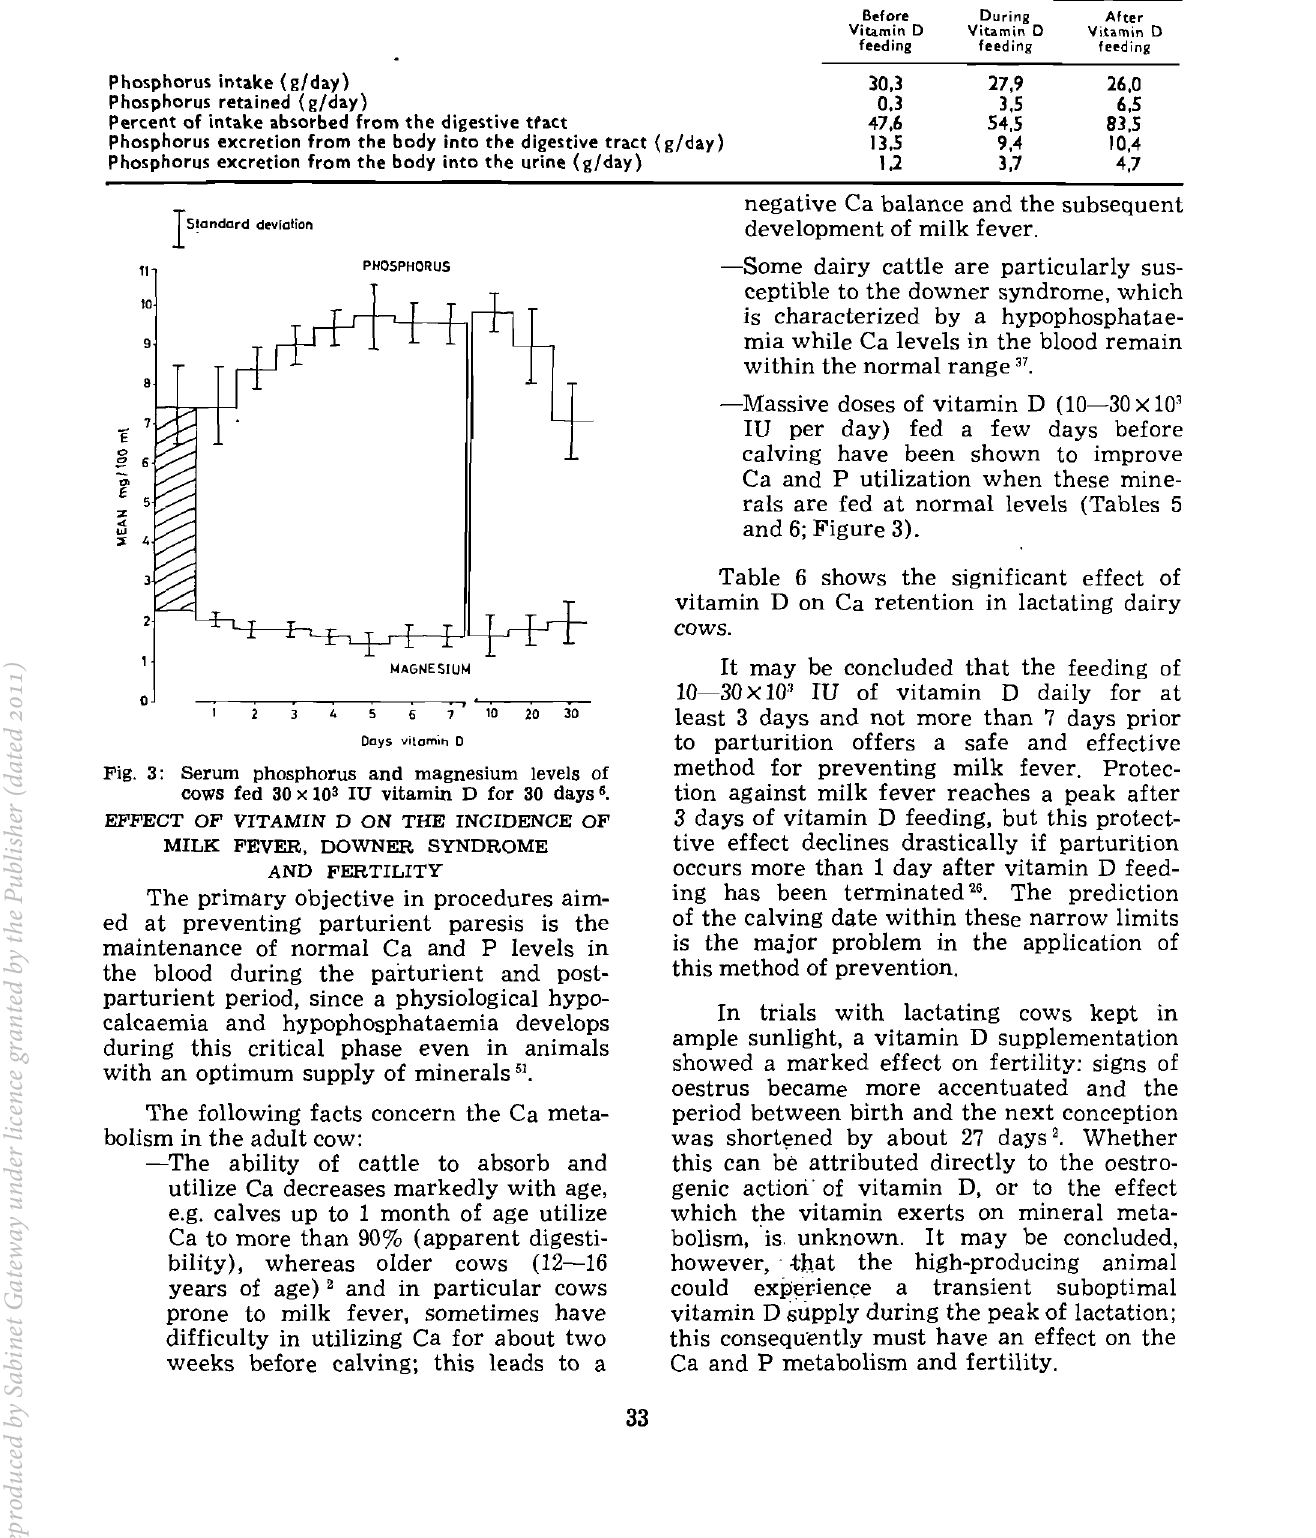
Table S: SOME EFFECTS OF FEEDING 20000000 IU VlrAMIN D PER. DAY ON PHOSPHORUS UTILIZATION BY MATUR.E STEERSB